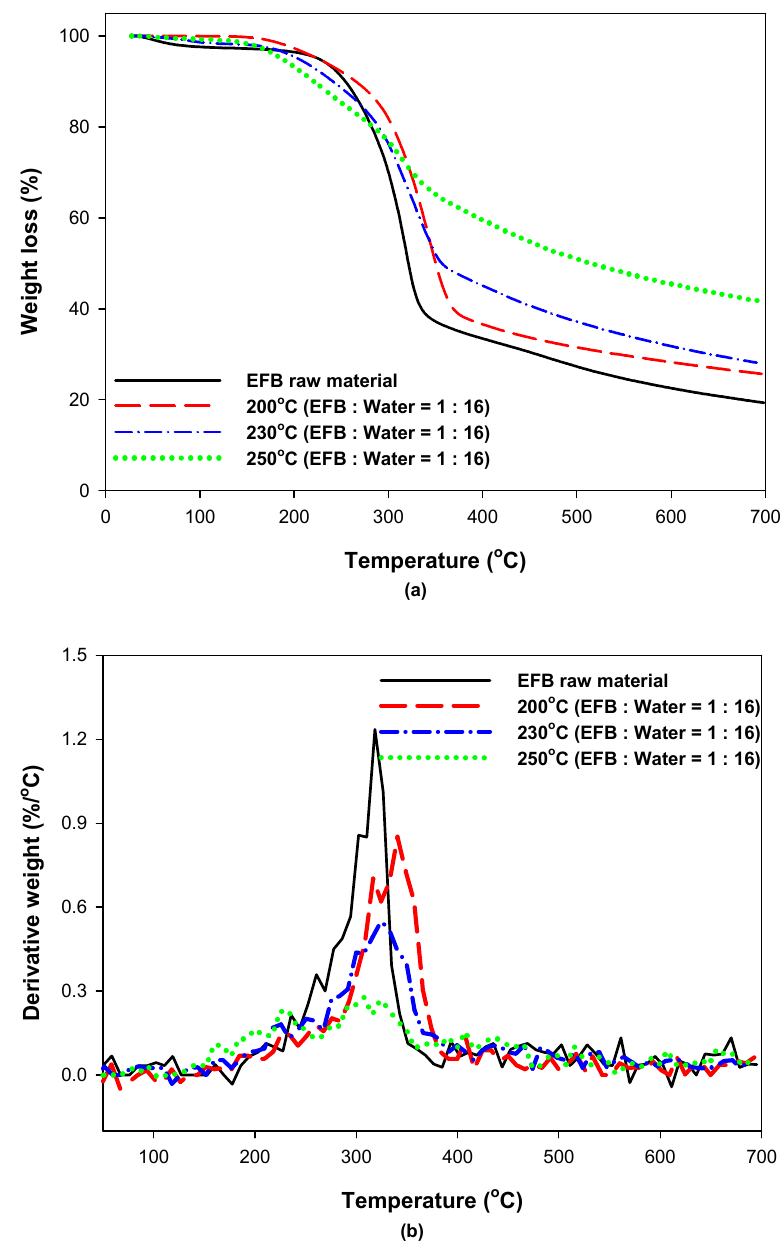
Figure 8. ( a ) TGA and ( b ) DTG curves of EFB according to reaction temperature (EFB:water = 1:16). Figure 9 shows the FT-IR spectra of the hydrothermally treated EFB under each exper- imental condition. The peaks between 3500 cm − 1 and 3200 cm − 1 represent the stretching of the O–H bonds of cellulose [32], whereas the peaks in the 2900 cm − 1 and 2800 cm − 1 sections represent stretching of the aliphatic C–H bonds of cellulose and hemicellulose [33]. In addition, the peaks in the 1700 cm − 1 and 1600 cm − 1 sections represent lignin-based C=C and C=O stretching, respectively [34]. Figure 9, however, shows that the peaks representing the O–H and C–H bonds of cellulose and hemicellulose hardly changed, but the peaks that represent lignin-based C=C and C=O stretching became more obvious compared to those of raw EFB after hydrothermal treatment. This appears to be due to the lignin content which decomposes at relatively high temperatures and relatively increases as the hydrothermal treatment temperature increased because of the decomposition of substances that decompose easily at low